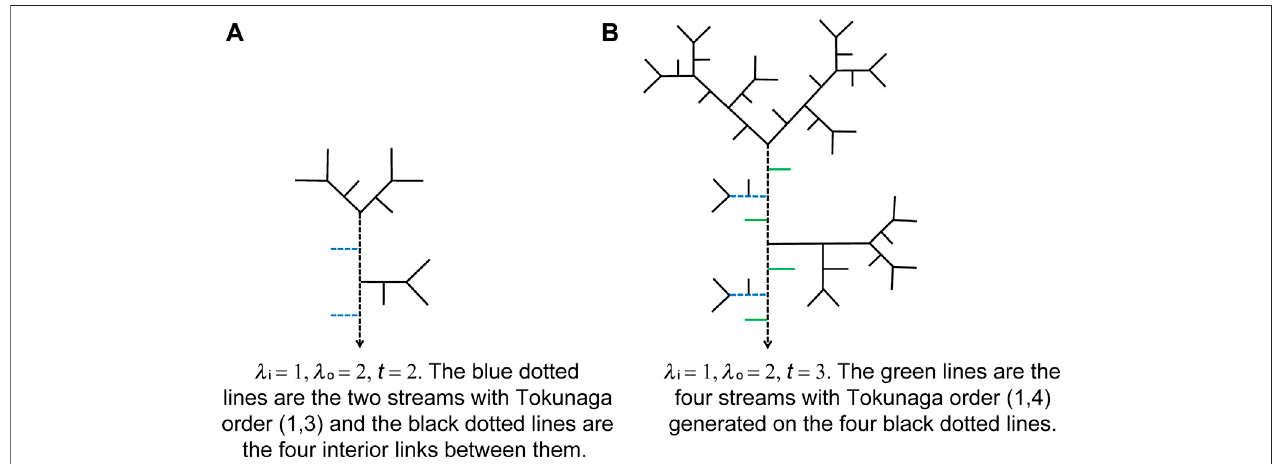
FIGURE 8 | Streams with Tokunaga order (1,4) in QU-IBTNs are generated using λ i (cid:2) 1, λ o (cid:2) 2 from the second step in (A) to third iterative step in (B) .